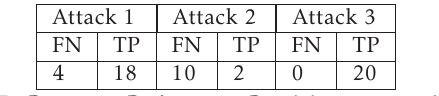
Figure 5. FPR and TNR for Detecting Attacks Exploiting Common Vulnerabilities does improve the detection performance despite the FNs. Table 7 shows a breakdown of the FN and TP among the three attacks.